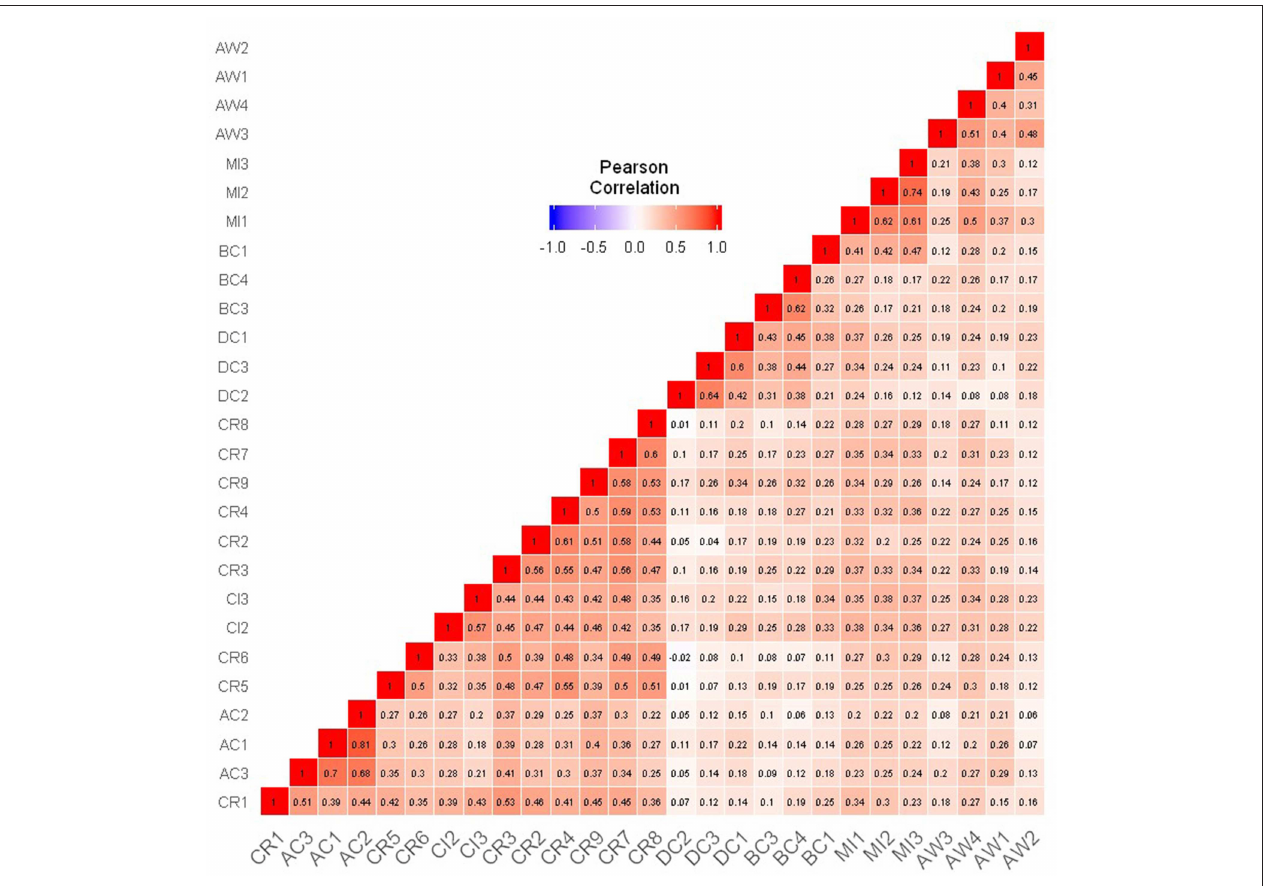
FIGURE 2 | Inter-item correlations for